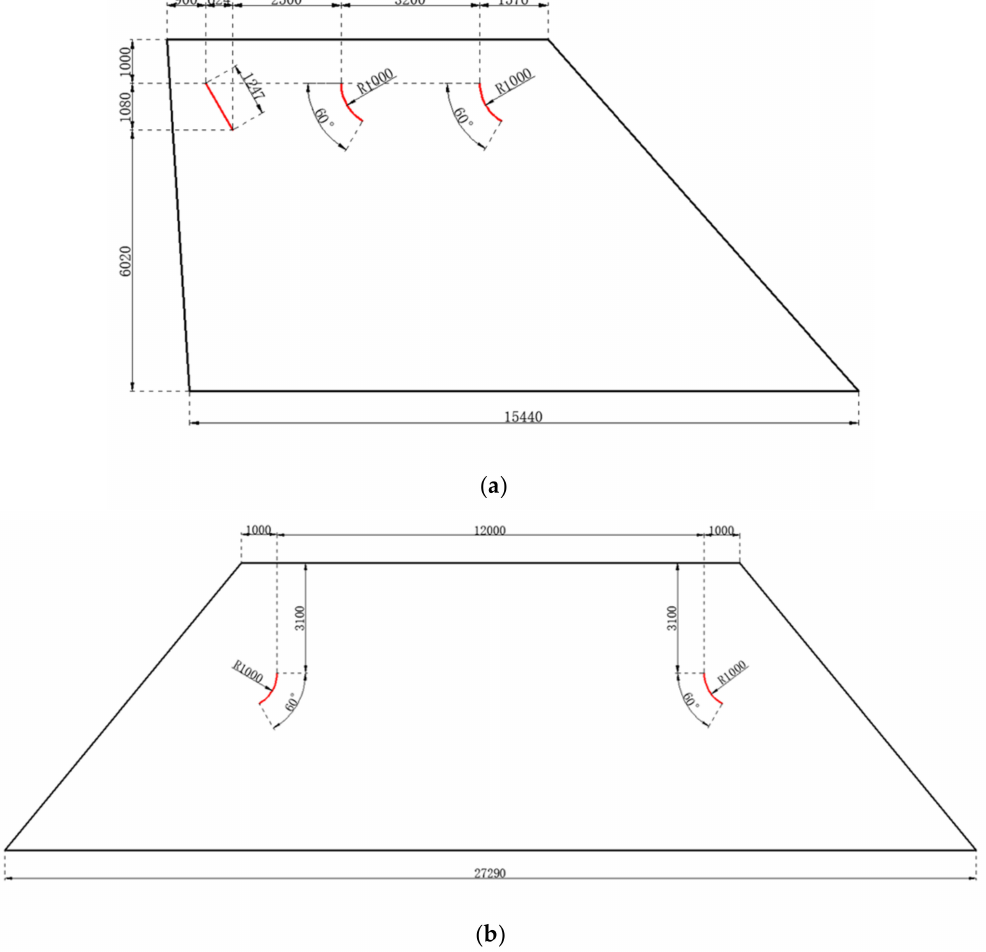
Figure 6. The sizes and locations of the baffles installation in the expansion duct: ( a ) Y-positive view; ( b ) X-negative